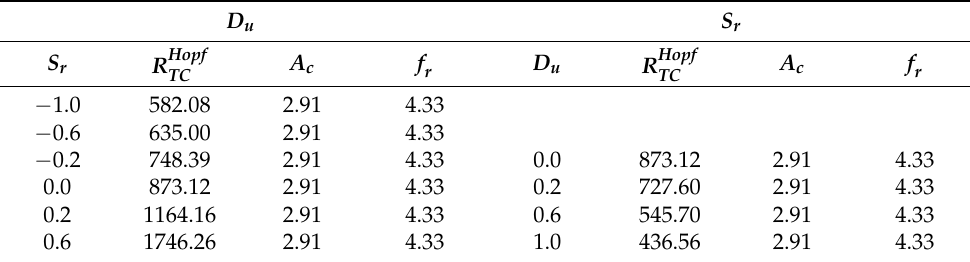
Table 4. Effects of the Soret, S r , and Dufour, D u , parameters on the threshold of the Hopf